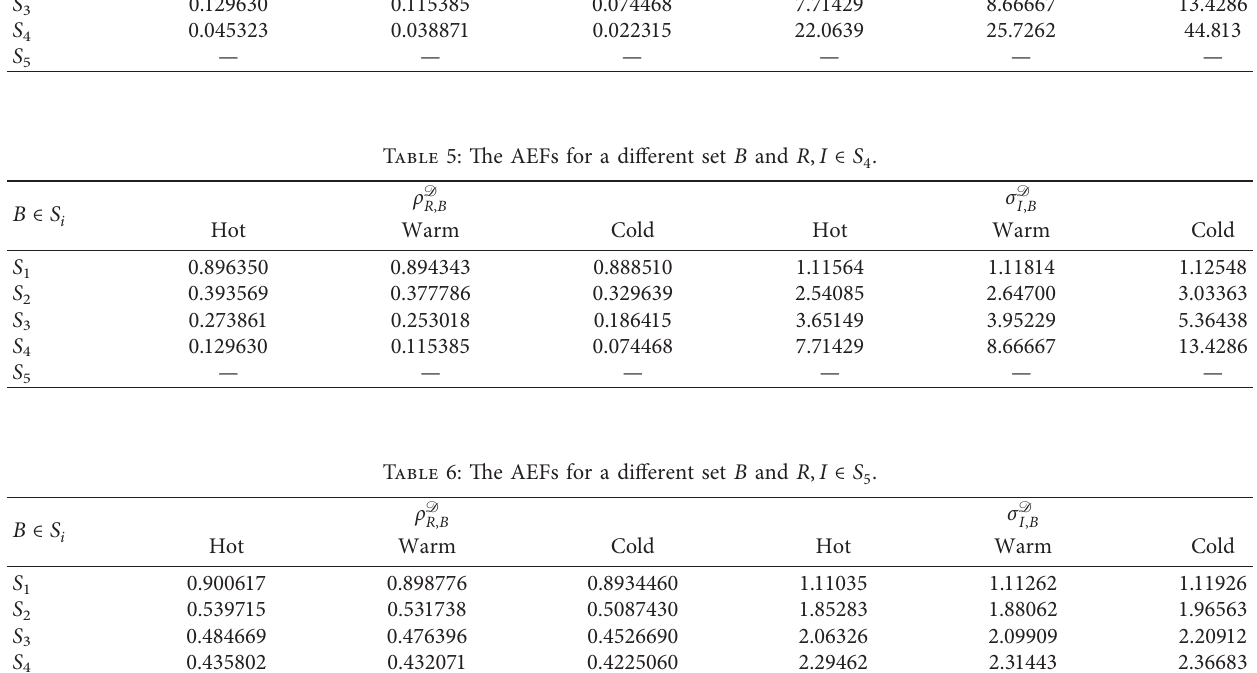
Table 4: The AEFs for a different set B and R,I ∈ S